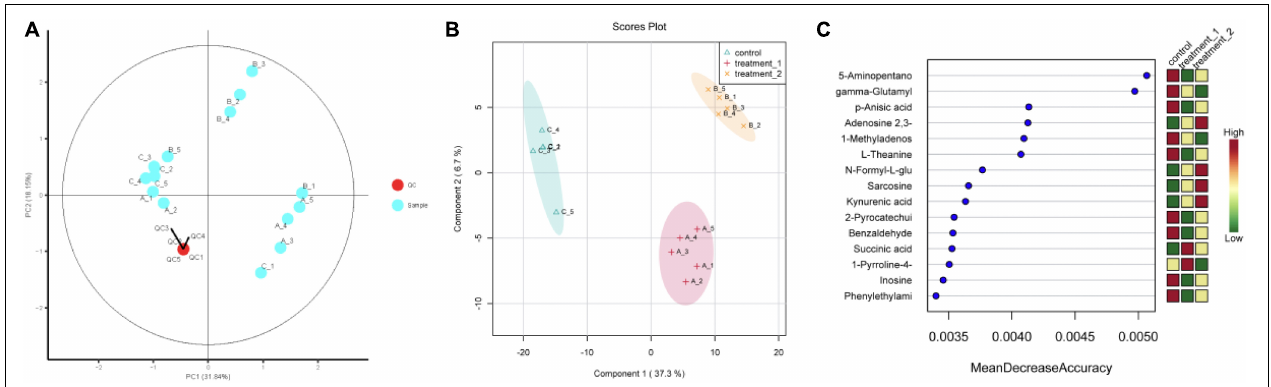
FIGURE 5 | (A) Quality control sample PCA chart; (B) PLS-DA point cloud; (C) variable importance in project corresponding to the PLS-DA. The abscissa of (C) (Mean Decrease Accuracy) measures the importance of a metabolite in random forests. The right figure is the heat map of the content of metabolites in the two groups in 15.) Treatment 1 corresponds to group A (OFL concentration is 10 mg/L); treatment 2 corresponds to group B (OFL concentration is 5 mg/L); Control does not add